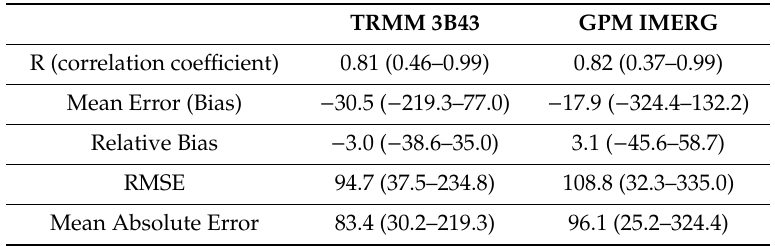
Table 4. Performance evaluation metrics of annual data from 3B43V7 and IMERG and (the range of values is given in parentheses).